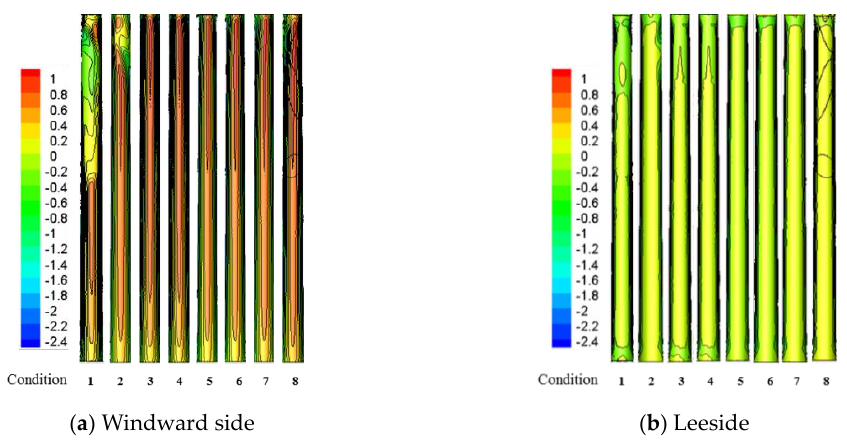
Figure 12. Contour map of wind pressure coefficient on the tower body under eight conditions. The contour map of wind pressure coefficients of three blades under eight conditions under typhoon loads is shown in Figure 13.